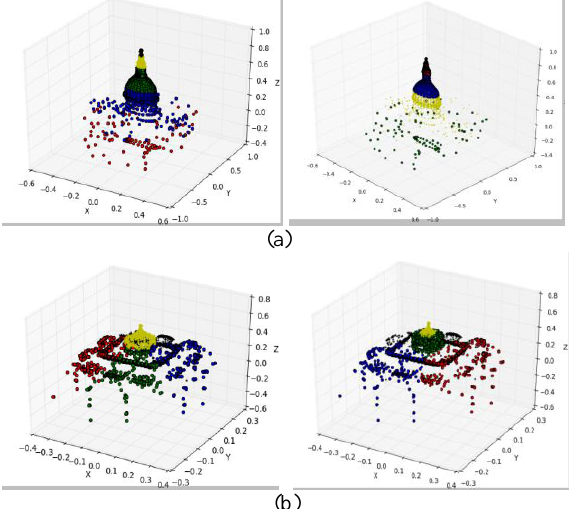
Figure 6. The left column is the results of using K-means++. The right column is the results of using